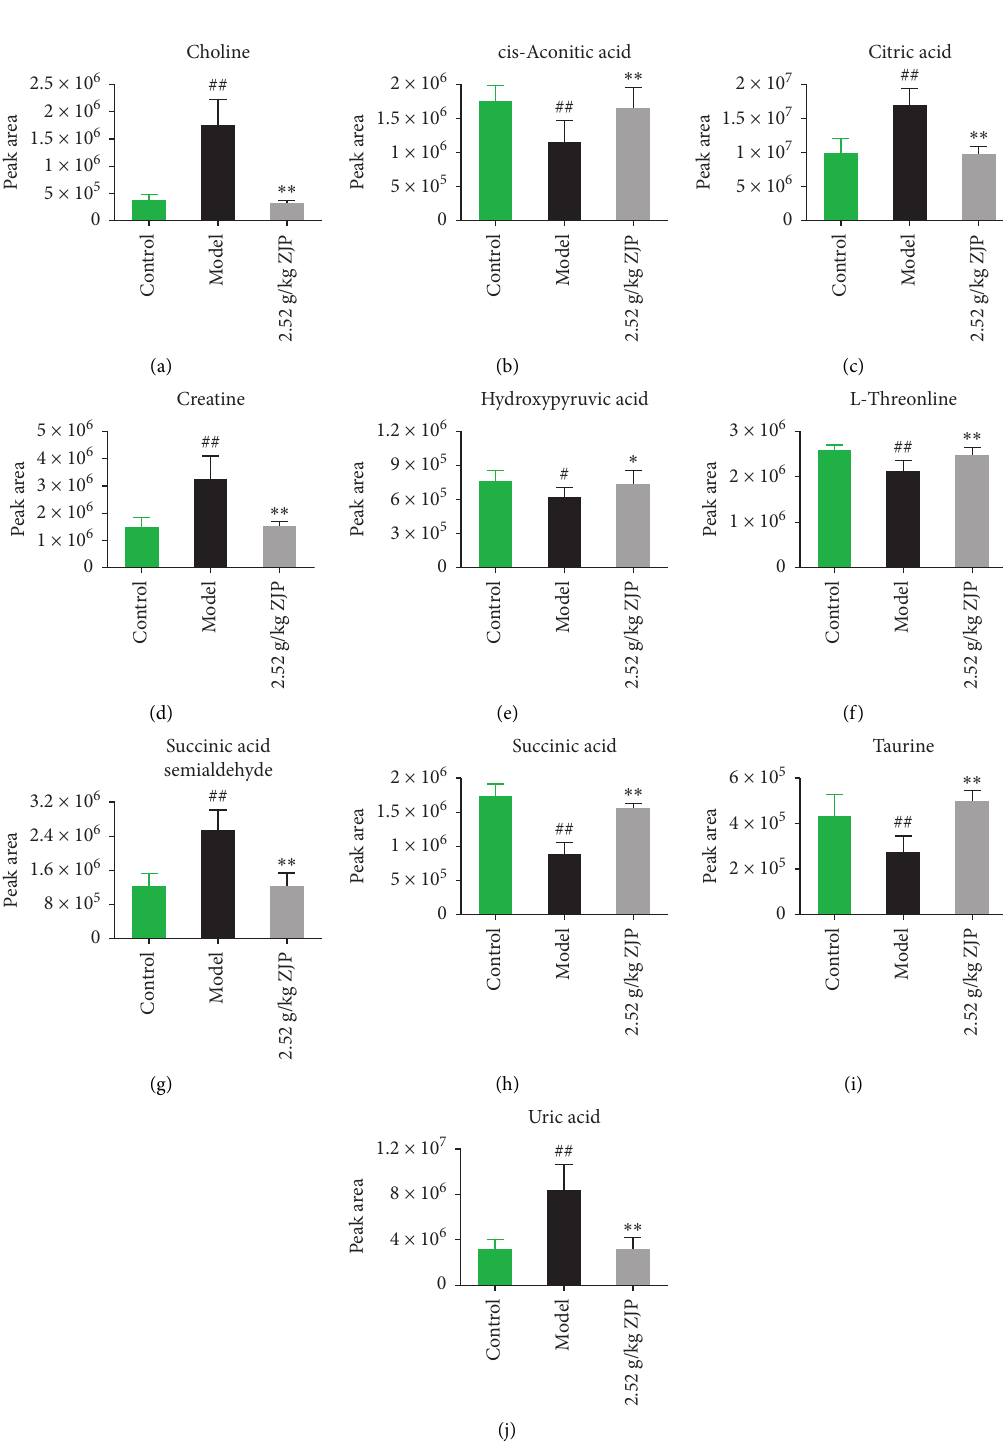
Figure 6: Potential metabolites changes in H. pylori -induced rats with ZJP treatment. (a) Choline. (b) cis-Aconitic acid. (c) Citric acid. (d) Creatine. (e) Hydroxypyruvic acid. (f) L-Threonine. (g) Succinic acid semialdehyde. (h) Citric acid. (i) Taurine. (j) Uric acid. # P < 0.05 and ## P < 0.01, compared with the control group. ∗ P < 0.05 and ∗∗ P < 0.01, compared with the model